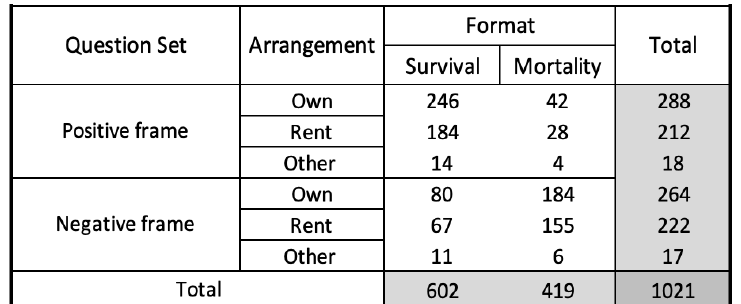
Figure 9. Respondent totals by living